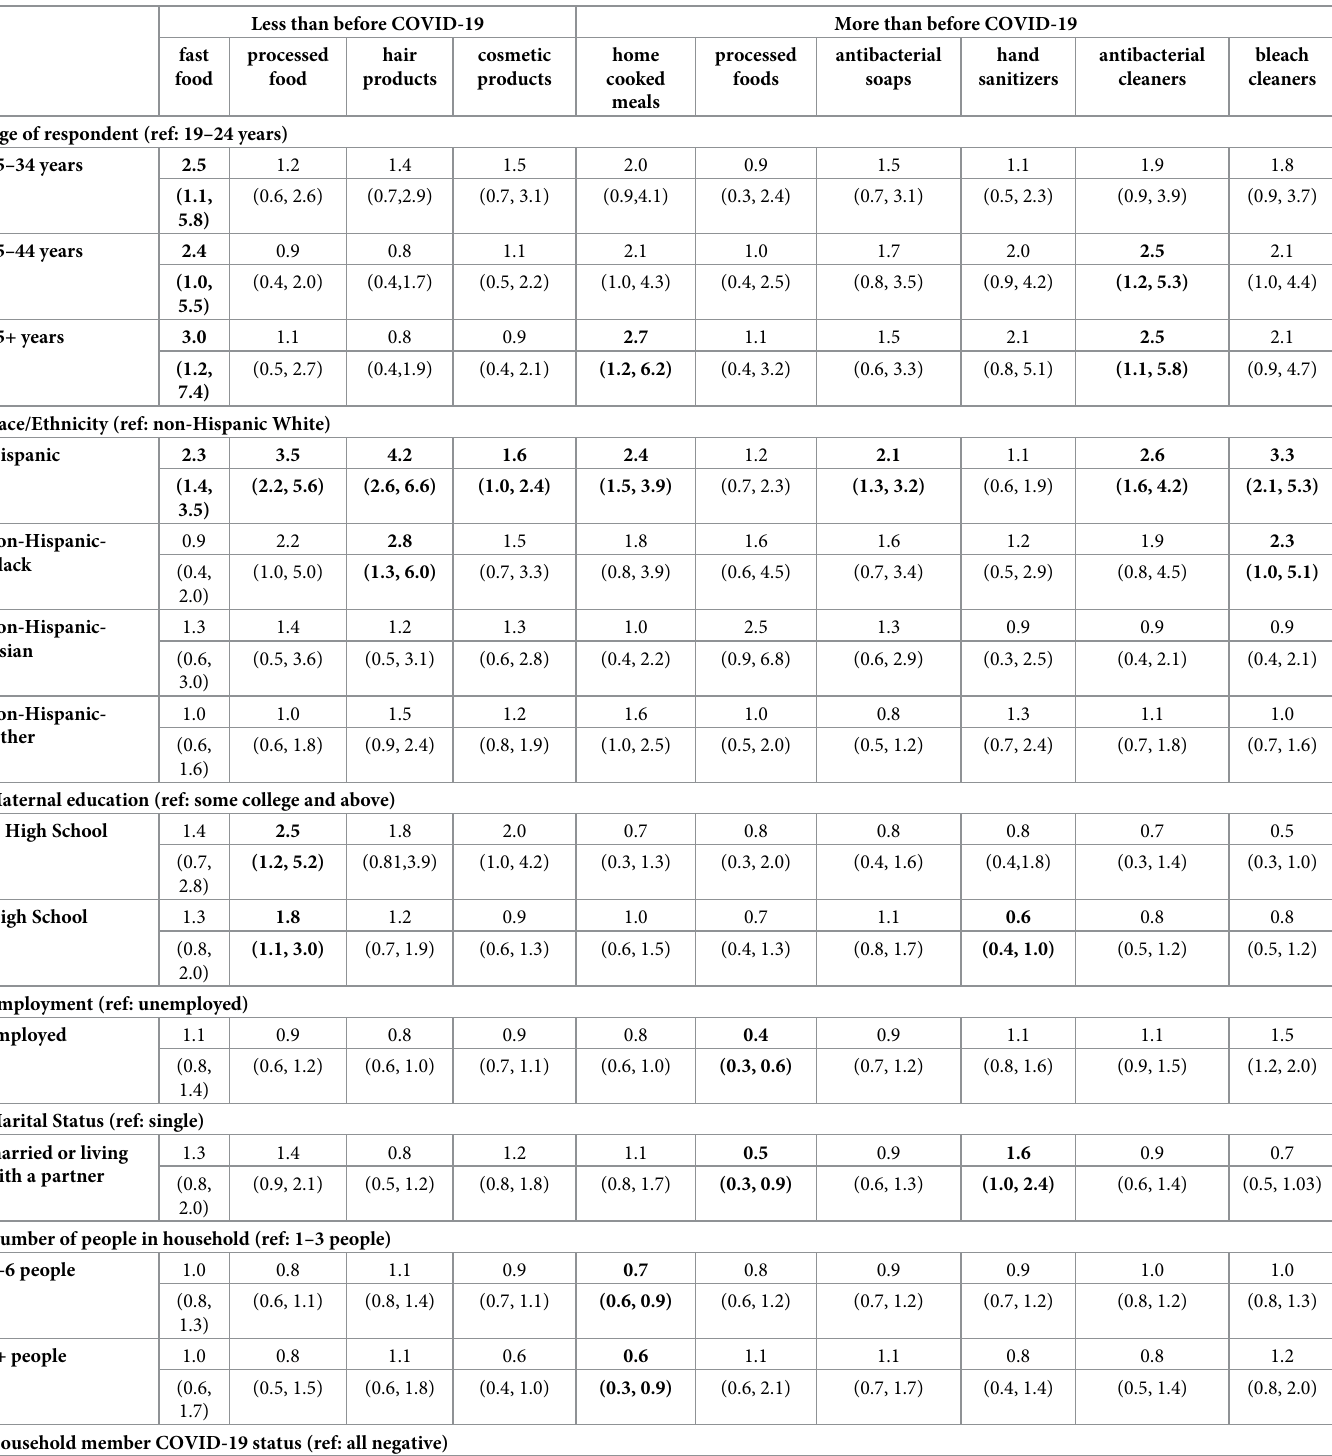
Table 2. Odds ratios and 95% confidence intervals � from multivariate models for key exposures and behaviors of interest �� .